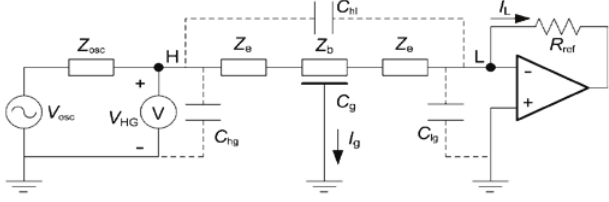
Fig.1: Equivalent circuit for impedance measurements based on an auto-balancing